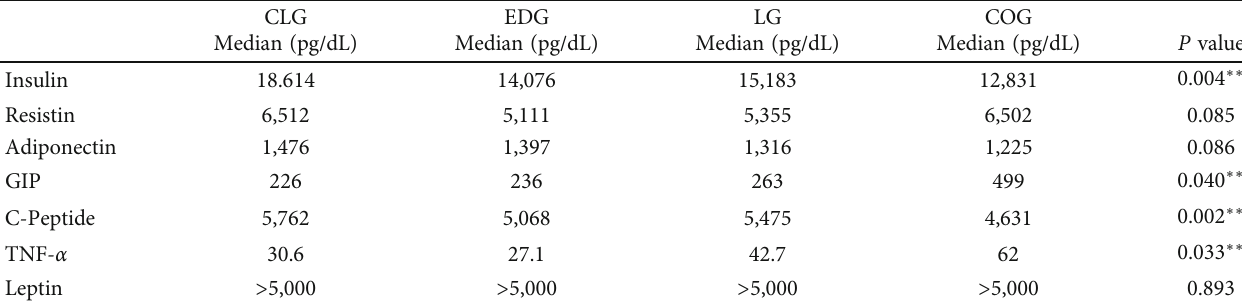
Table 5: Hormone and in fl ammatory pro fi le of supplemented and control mice for 8